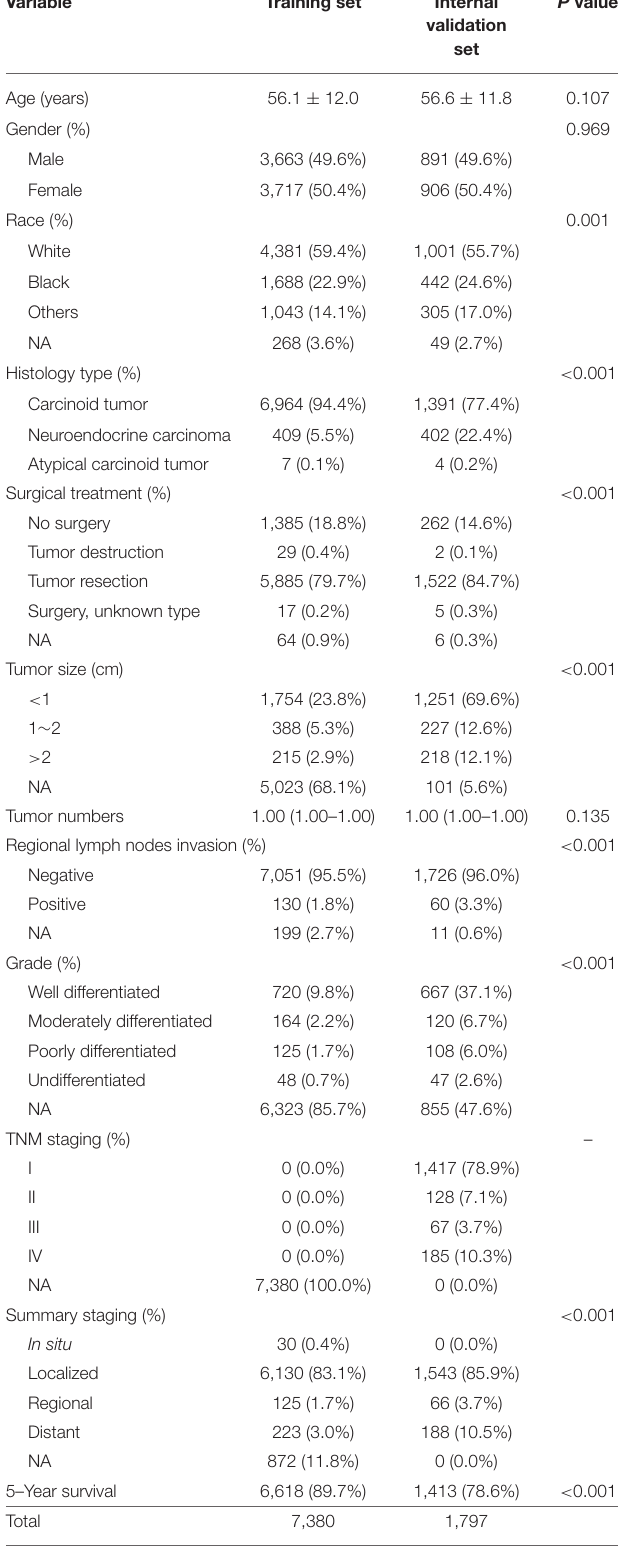
TABLE 4 | Main characteristics of training set and internal validation